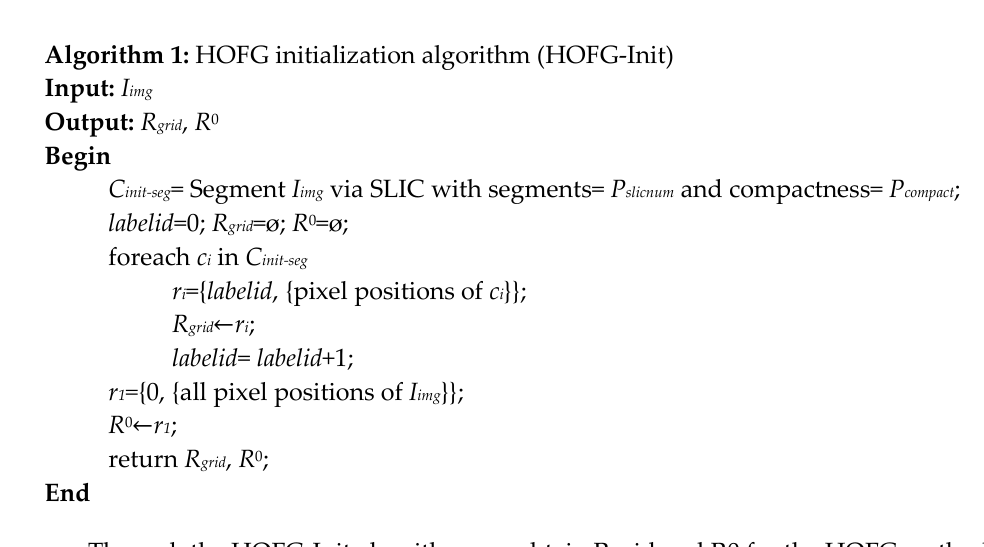
Algorithm 1: HOFG initialization algorithm (HOFG-Init)